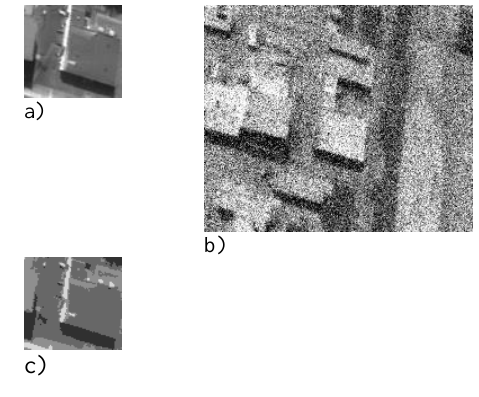
Figure 5. Example 2: a) etalon TV fragment; b) test IR image; c) segmented TV fragment.